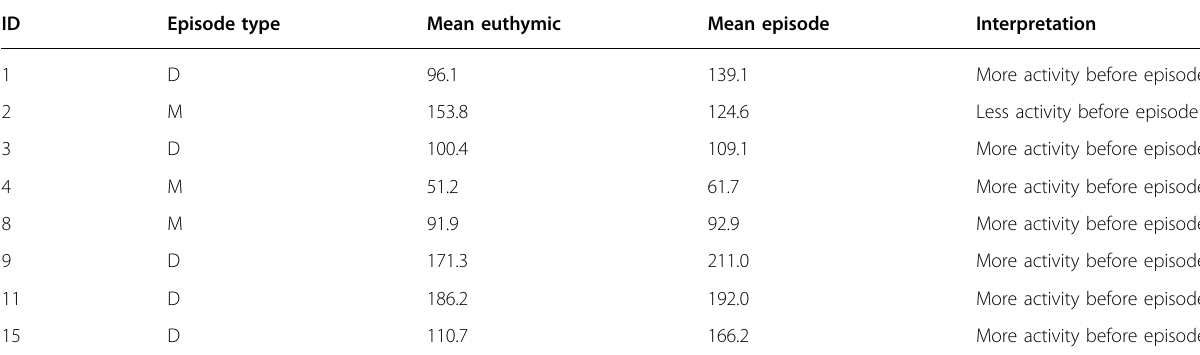
Table 2 Mean activity during seven-day periods before bipolar episodes and during euthymic